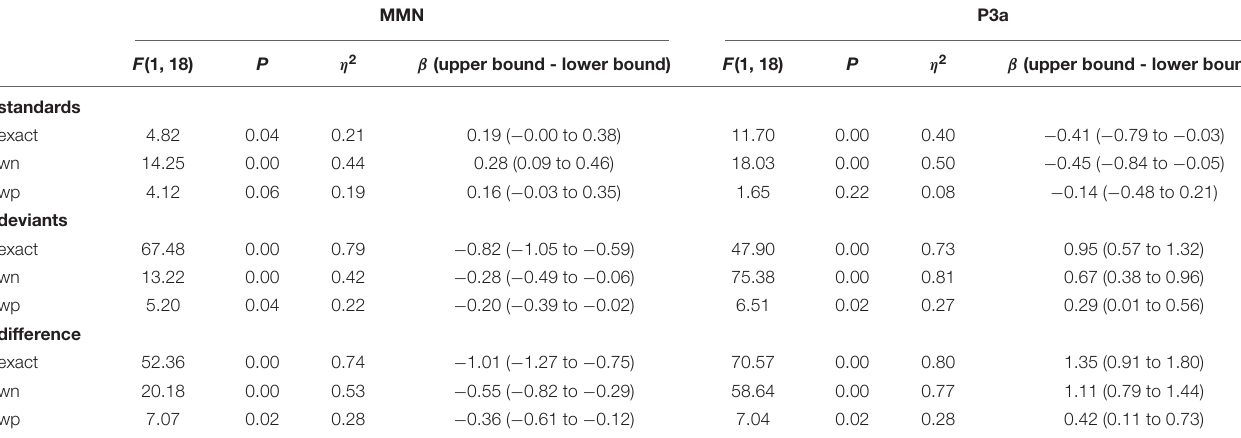
TABLE 1 | Logarithmic trend and regression analysis for the main effect of train length on MMN and P3a